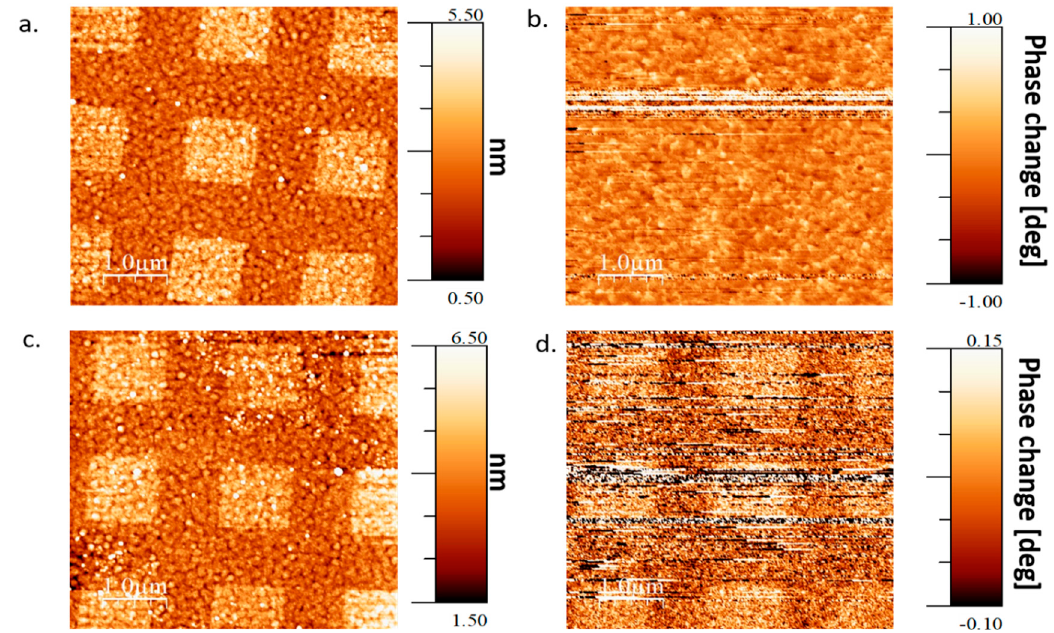
Figure 3 . Topography and magnetization with applied IP external magnetic field. a . Topography of a Figure 3. Topography and magnetization with applied IP external magnetic field. ( a ). Topography of L-AHPA SAM in an IP easy axis Co wedge area. b . Magnetization of same area as shown in a. c . a L-AHPA SAM in an IP easy axis Co wedge area. ( b ). Magnetization of same area as shown in ( a ). Topography of a SAM in an OoP easy axis wedge area. d . Magnetization of the SAM in the same OoP ( c ). Topography of a SAM in an OoP easy axis wedge area. ( d ). Magnetization of the SAM in the same easy axis wedge area as in c. OoP easy axis wedge area as in ( c